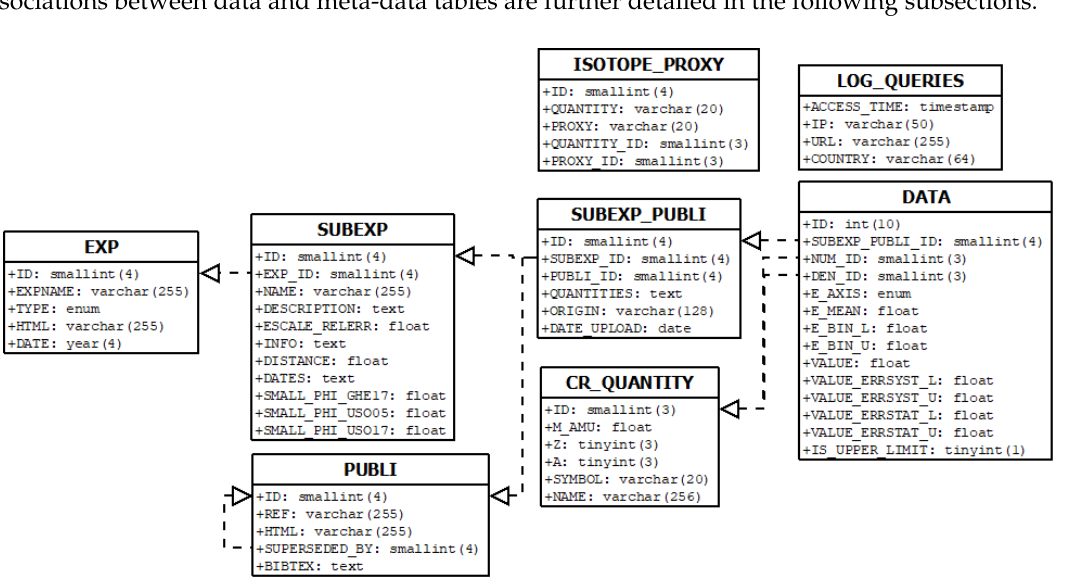
Figure 1. Tables and keys of the database MySQL structure. The data are stored in the DATA table (Section 2.1) with CR names defined in the CR_QUANTITY table. The meta-data related to experiments are stored in EXP (Section 2.2.1) and SUBEXP tables (Section 2.2.2), while those related to